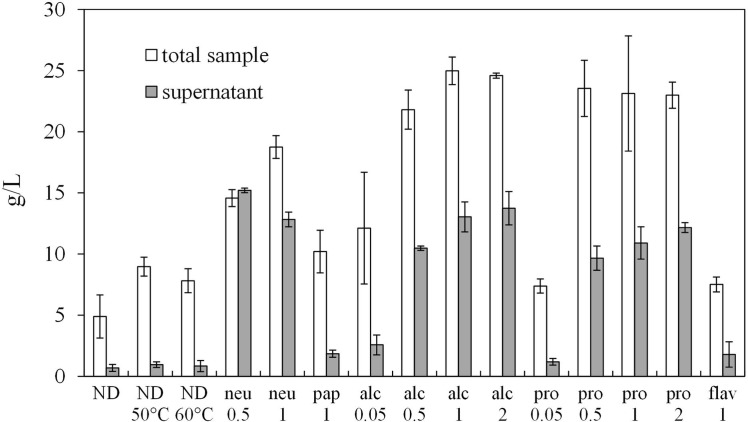
Protein quantification on total and supernatant samples.Enzymatic hydrolyses (2 hours) with Neutrase (neu), papain (pap), Alcalase (alc), Protamex (pro) and Flavourzyme (flav), were performed. Numbers under the enzyme abbreviations indicate the E/S ratio in U/g (unit of enzyme per g of protein). Results are expressed as g of protein per litre of digestate (g/L) ± SD (at least n = 4).